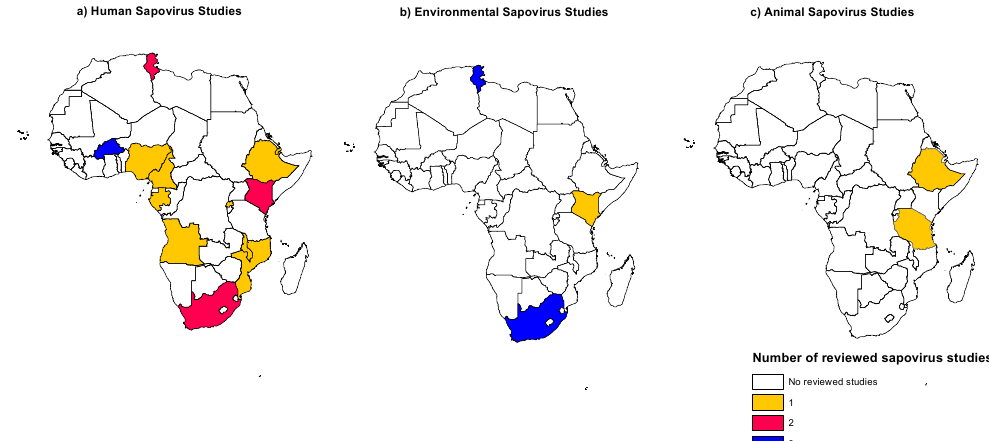
Figure 1. Map of Africa showing the countries where ( a ) human ( b ) environmental, and ( c ) animal sapovirus studies were published, Jan 2005–Mar 2019. The different colors indicate the number of studies published per country, while white indicates no data available .